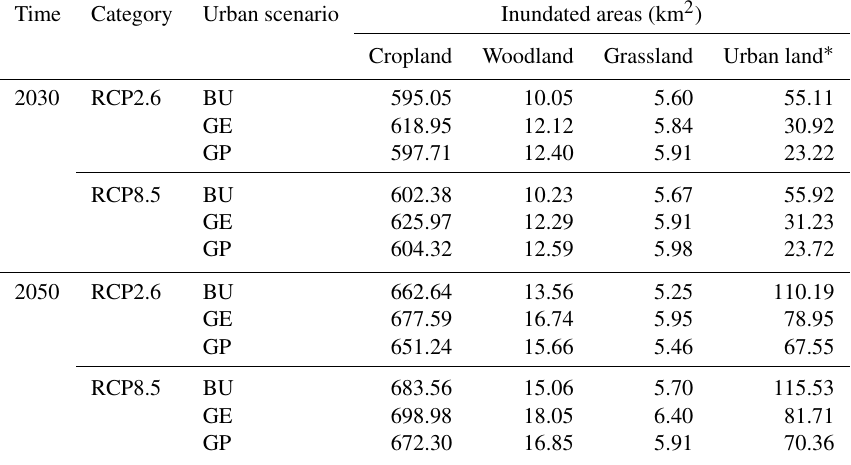
Table 3. Inundation of each land use type under different scenarios. The inundated areas of different land use types, including cropland, woodland, grassland and urban land, were calculated for each scenario, where ∗ indicates new-growth areas of the urban class affected by